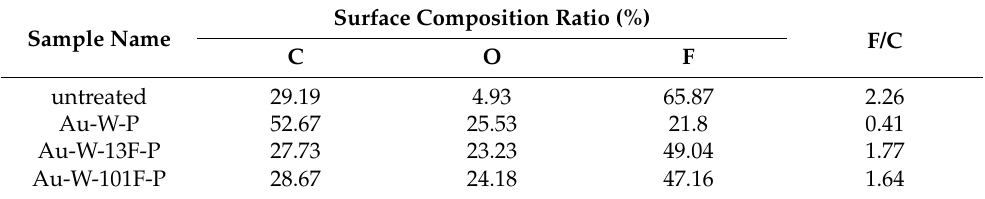
Table 2. Surface elemental composition of PTFE samples evaluated from XPS results (Figure